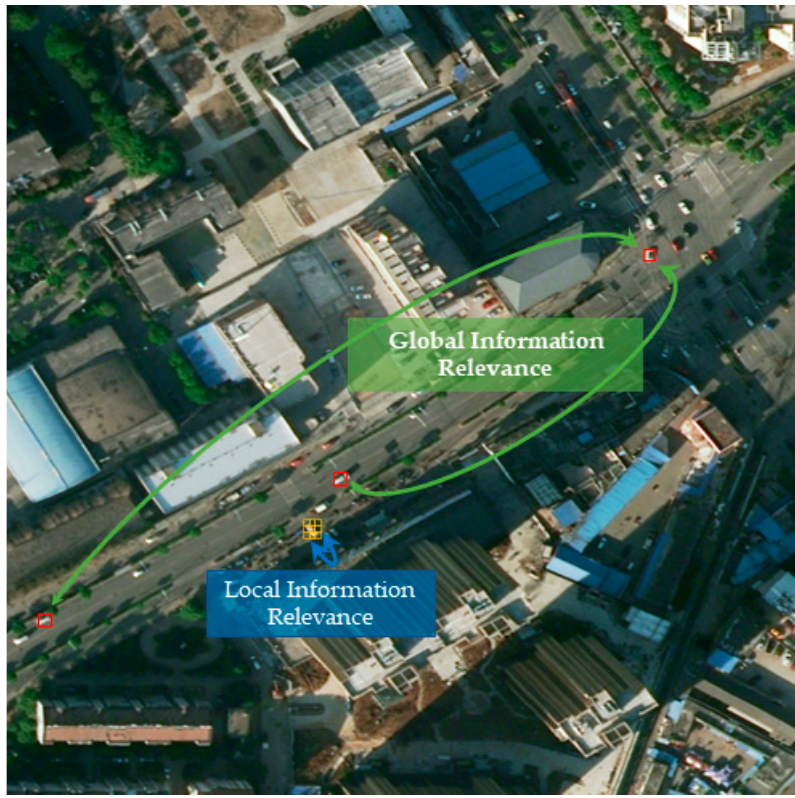
Figure 7. Global and local information dependencies. Local dependencies are presented by convo- lution (yellow). The long-distance boxes (red) present the global dependencies.